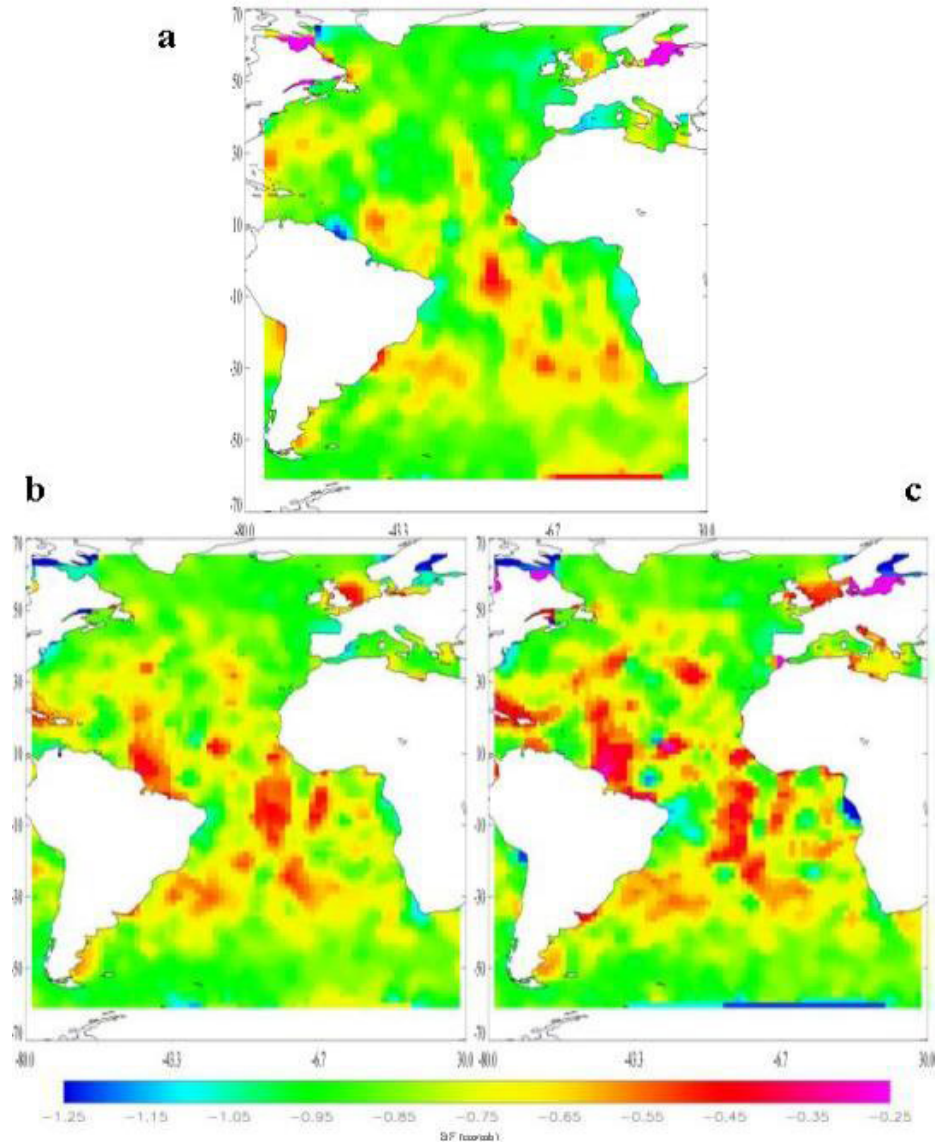
Fig. 3. Geographical distribution of BF in the Atlantic Basin, obtained for the three time samplings considered. (a) 1t = 35days, (b) 1t = 11days and (c) 1t =